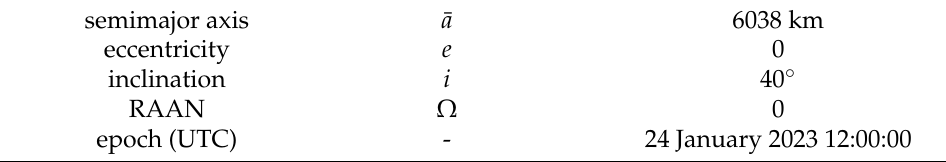
Table 10. Lunar formation: orbit parameters of chief satellite.